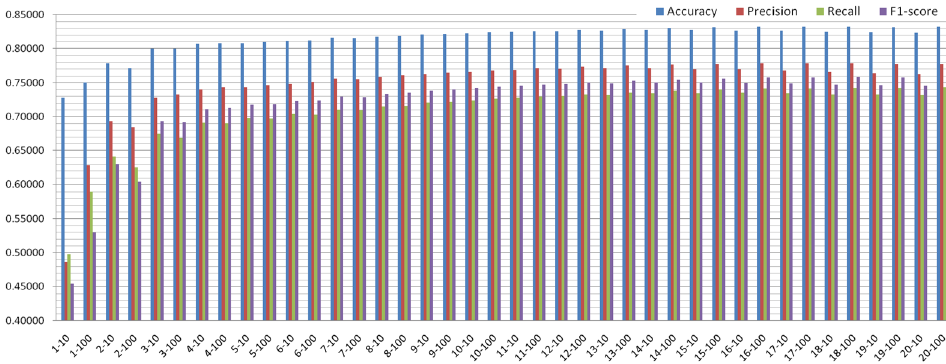
Figure 7. Evaluation indicators of the random forest. Table 5. Validation results of the indicators in the optimal random forest